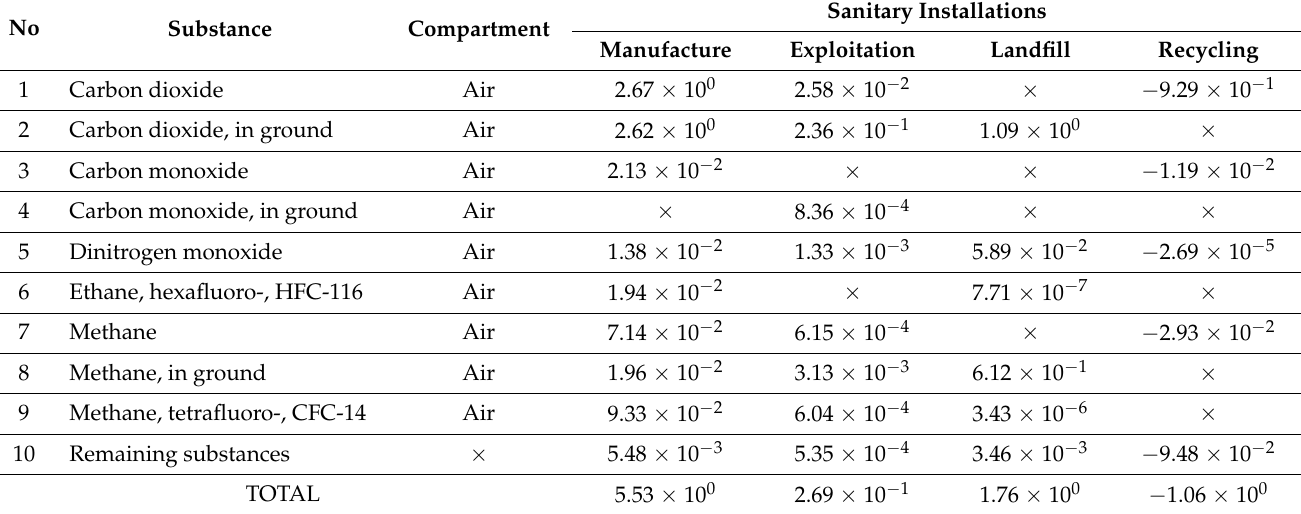
Table 9. The results of grouping and weighing the environmental consequences of emissions of compounds causing global warming due to sanitary installations occurring at individual stages of the life cycle of the research